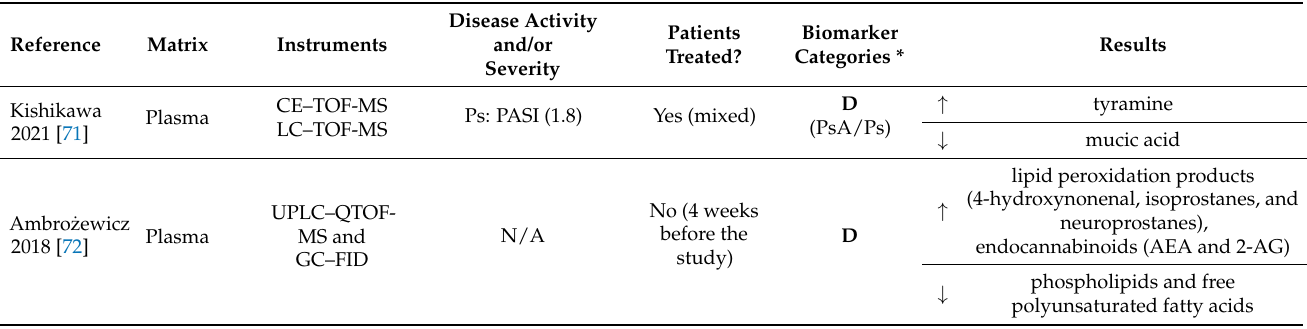
Table 2. Changed metabolites in psoriatic arthritis (PsA). Biomarker category highlighted in bold: Corresponding metabolites listed in column